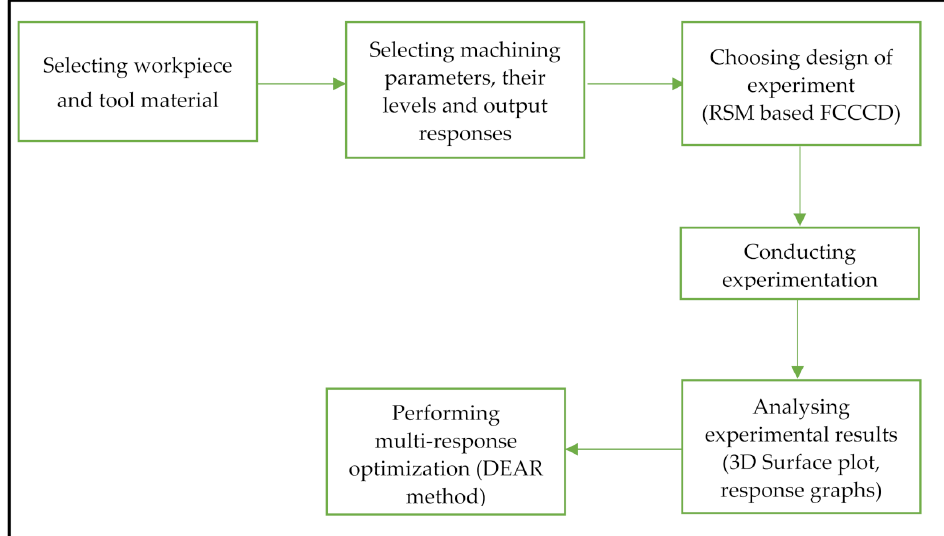
Figure 1. Research Workflow.